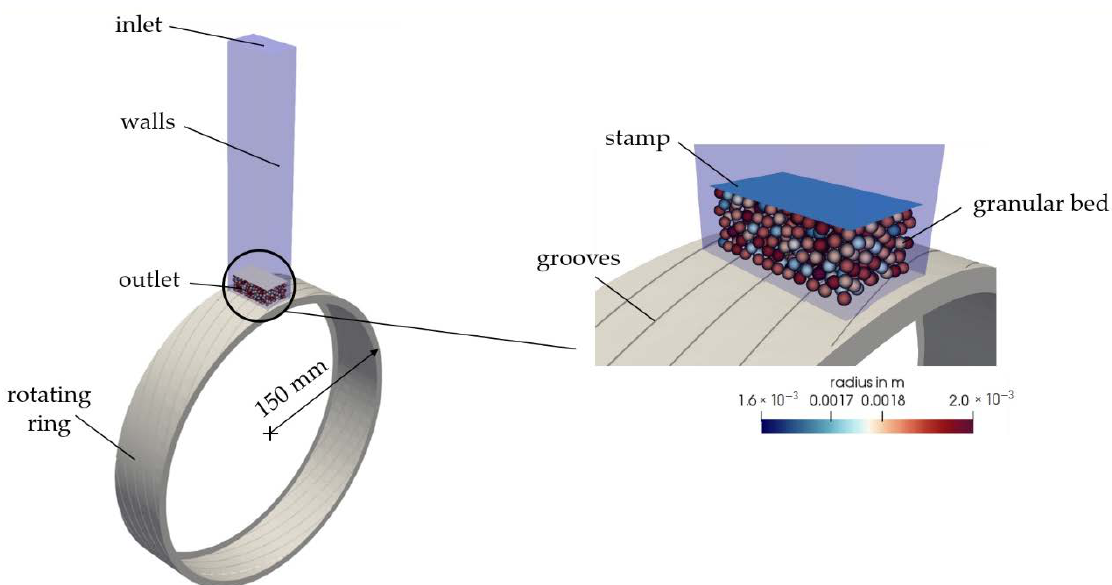
Figure 4. CFD-discrete element method (DEM) model of the melting apparatus. The CFD domain is shown in